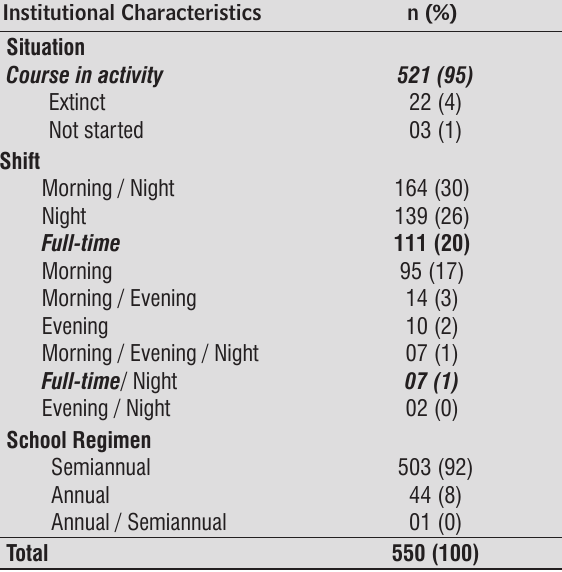
Table 2 - Distribution and percentage of Higher Education